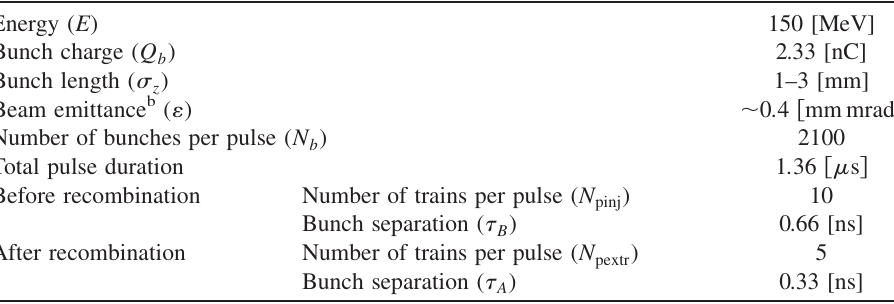
TABLE I. Main beam parameters at the injection/extraction of the DL a .